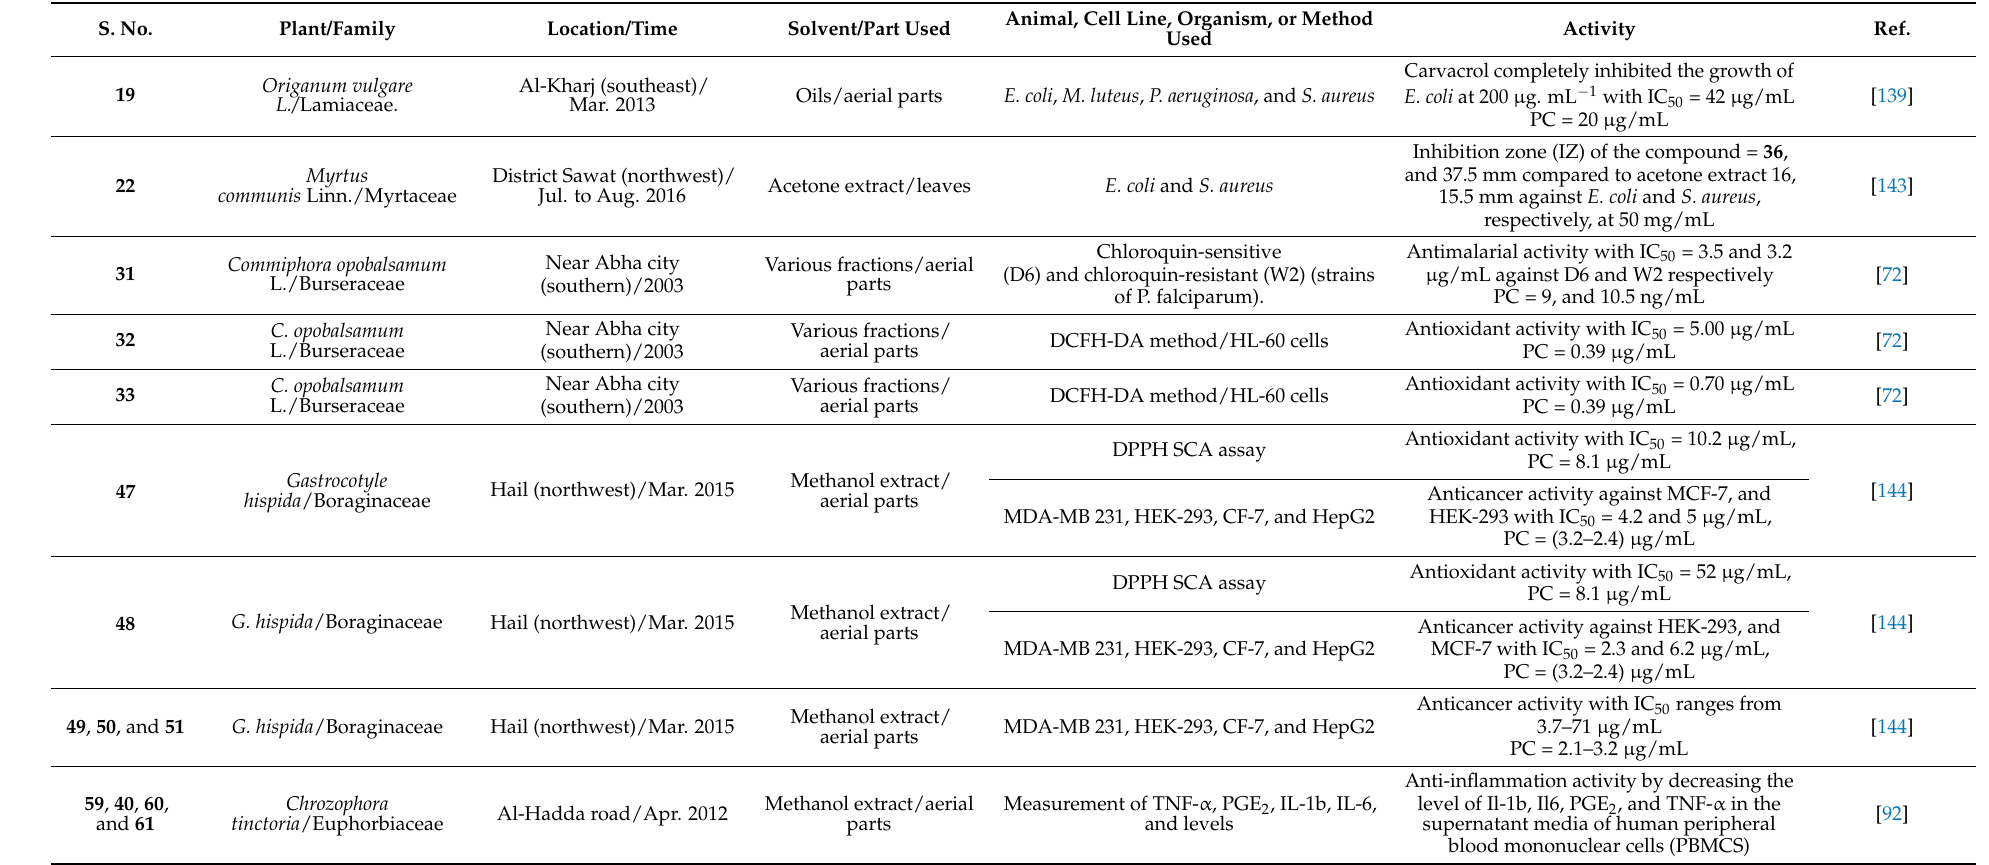
Table 3. The biological activities of isolated compounds from plants in various regions of